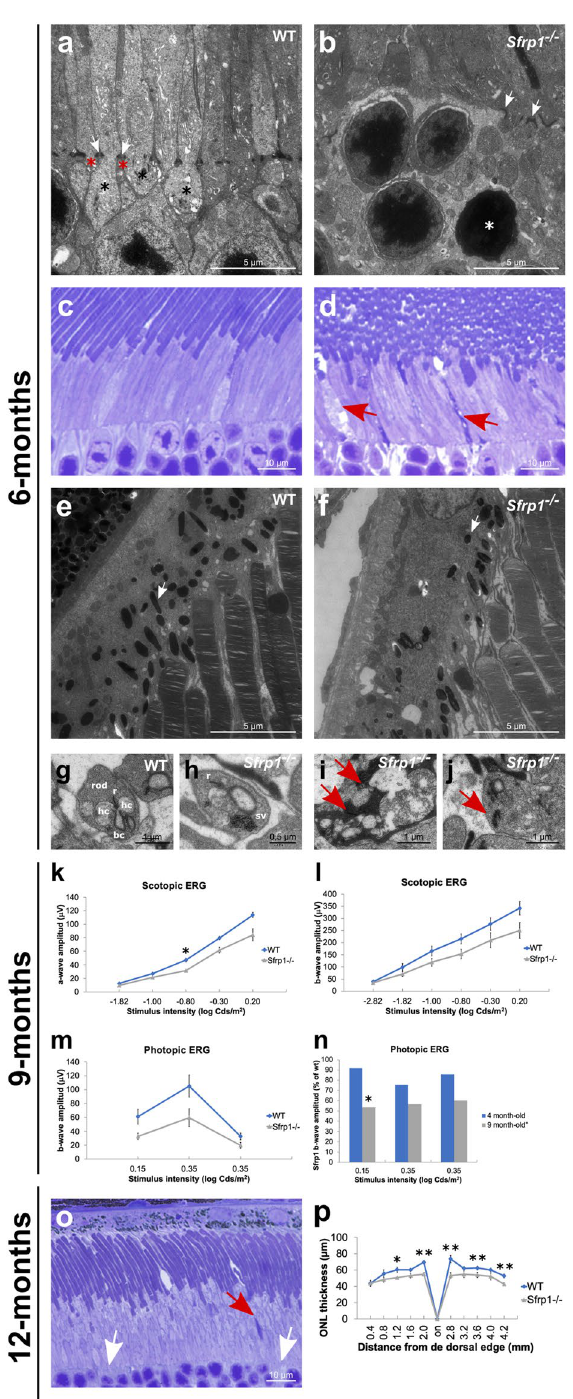
Figure 4. OLM is disrupted in the retina of Sfrp1 − / − mice in association with an impoverishment of visual function. ( a , b ; e – j ) TEM analysis of the retina from 6 months-old wt and Sfrp1 − / − mice. Images show the OLM ( a , b ), RPE ( e , f ) and photoreceptor-bipolar cells synapses ( g – j ). White arrows in a,b point to adherens junctions between Müller glial cell end-feet (red asterisks) and photoreceptors (black asterisks). White arrows in e,f point to melanosomes. Red arrows in i,j indicate synaptic terminal disorganization. ( c , d) Semi-thin frontal sections from 6 months-old wt and Sfrp1 − / − retinas stained with toluidine blue. Note the abnormal presence of degenerating outer segments in the mutant retina (red arrows in d). ( k , l ) The graphs show the ERG recordings of rods and rod bipolar cells (scotopic, k , l ) and cone –pathway (photopic, m ) response to light of 9 months- old wt and Sfrp1 − / − animals. ( n) The graph represents the activity of photoreceptors from 4 and 9 months-old Sfrp1 − / − mice. Note that activity is expressed as a percentage of wt age-matched animals. Only 9 months-old Sfrp1 mice showed a significantly reduced activity relative to their control. ( o) Semi-thin frontal sections from 10 months-old Sfrp1 − / − retina stained with toluidine blue. Note the continuous presence of